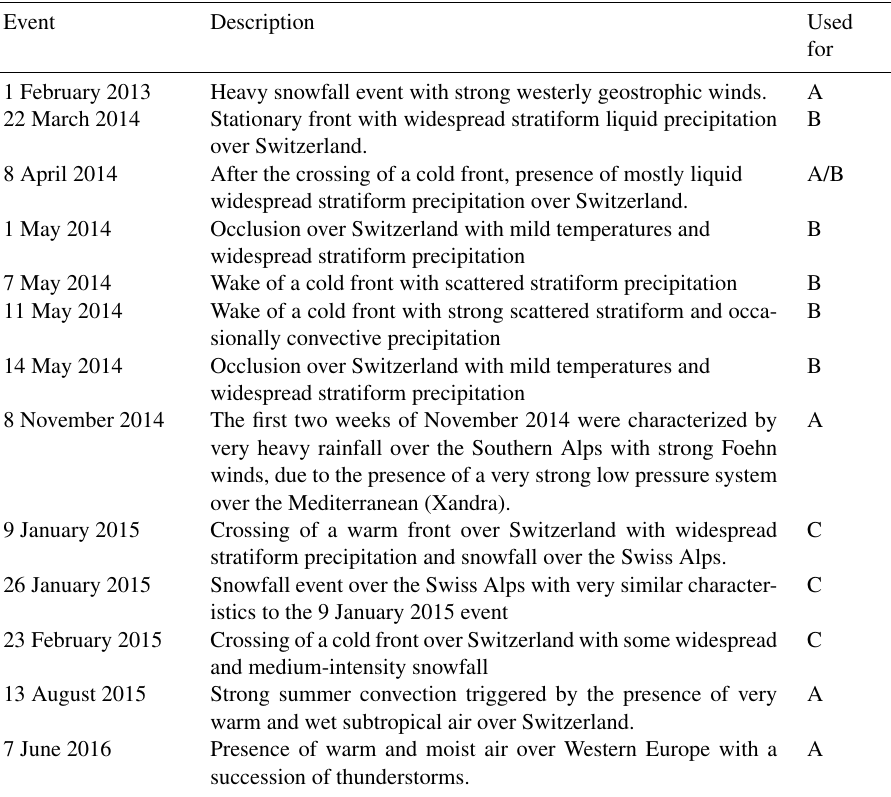
Table 3. List of all events used for the comparison of simulated radar observables with real ground radar observations. The last column indicates the context of the comparison. A indicates the comparison with the operational C-band radars (Sect. 4.3), B indicates the comparison with the X-band radar (Sect. 4.2), and the Parsivel data (Sect. 4.4) in Payerne and C indicates the evaluation of ice crystals with the X-band radar in the Swiss Alps in Davos (Sect.